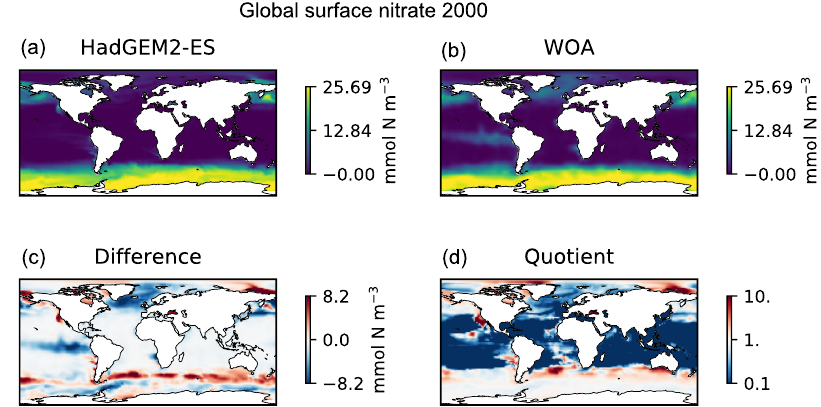
Figure 9. Four spatial distributions showing the model (a) , the observational data (b) , the difference between them (c) , and their quotient (d) . The model data in these plots are the global surface nitrate in HadGEM2-ES in the historical simulation in ensemble member r1i1p1 in the year 2000. The observational data come from the annual nitrate dataset in the World Ocean Atlas.